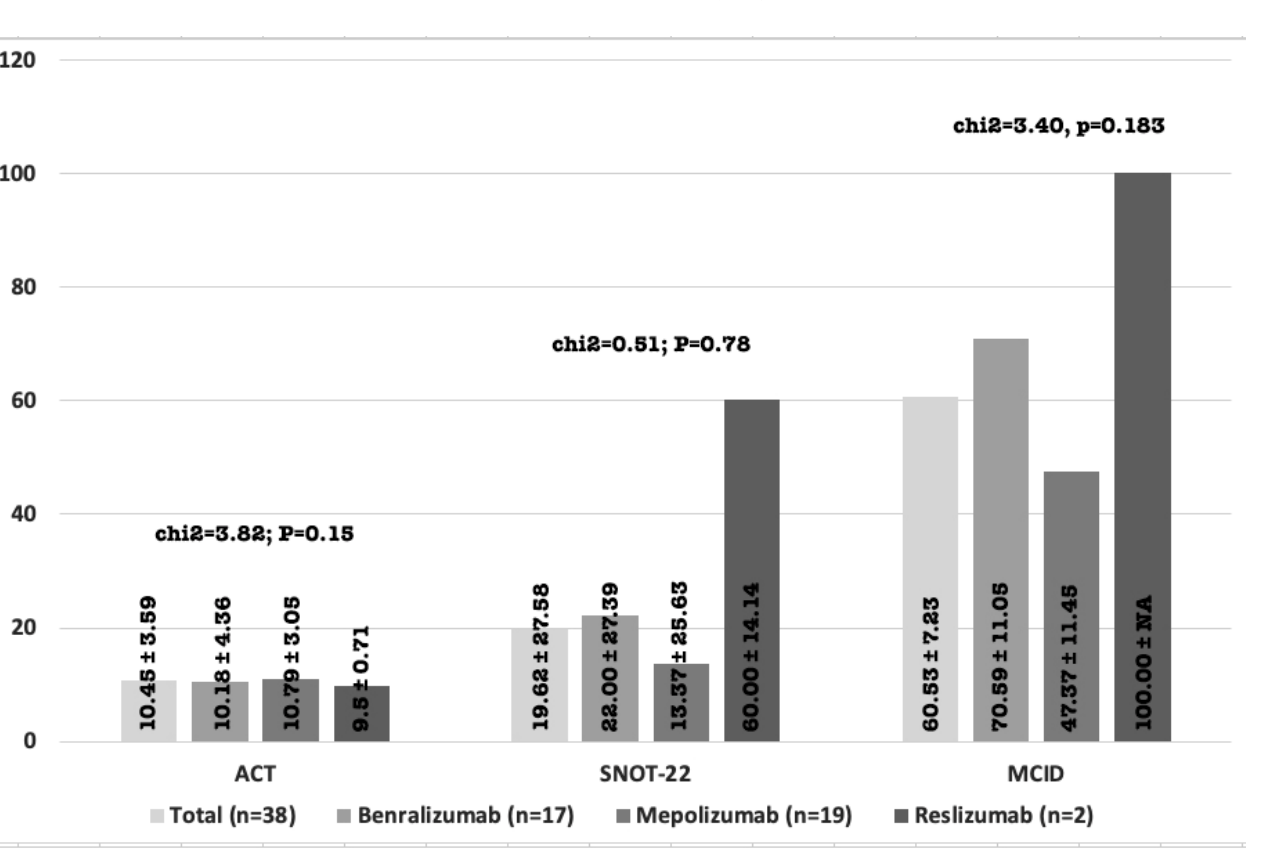
Figure 1. Clinical response to anti-IL-5 mAb therapy. Data in percentage of change. MCID